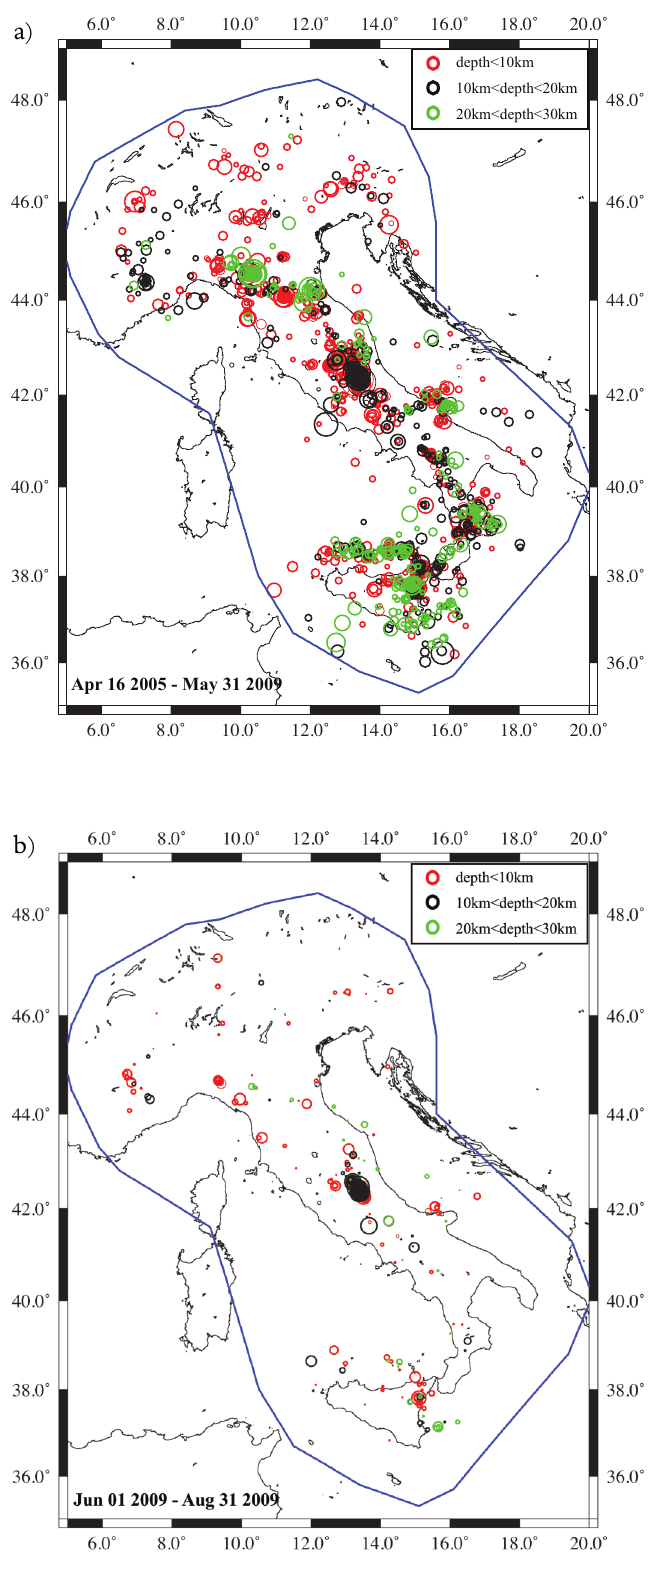
Figure 2. Maps of the seismic events with magnitudes >2.5 and depths <30 km that occurred in Italy inside the collection area identified by the CSEP experiment (blue solid line) [see Schorlemmer et al. 2010]. The symbol sizes are scaled with magnitude. a) Events of the learning dataset used to set-up the model (April 16, 2005, to June 1, 2009; 2,100 events). b) Events of the testing dataset used for the retrospective forecasting test of the model (June 1, 2009 to September 1, 2009; 179